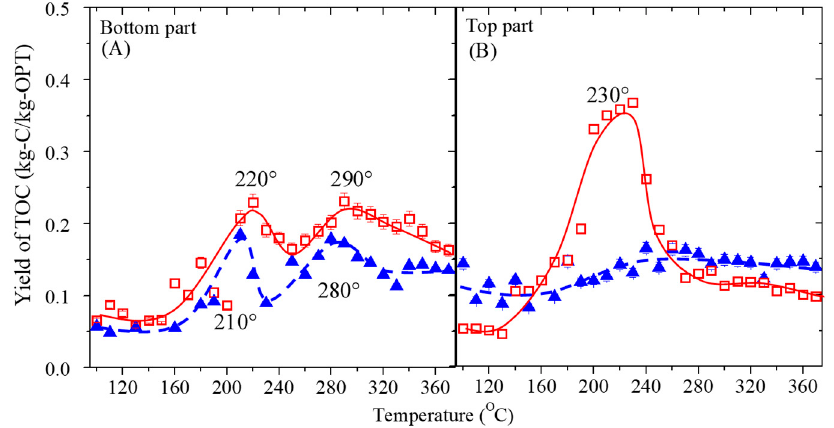
Figure 4. The e ff ect of the reaction temperature on the yield of TOC after OPT21 ( (cid:3) ) and OPT35 ( (cid:78) ) Figure 4. The effect of the reaction temperature on the yield of TOC after OPT21 ( □ ) and OPT35 ( ▲ ) were subjected to a sub-CW treatment for 5 min. ( A ) Bottom and ( B ) top were subjected to a sub-CW treatment for 5 min. ( A ) Bottom and ( B ) top sections.